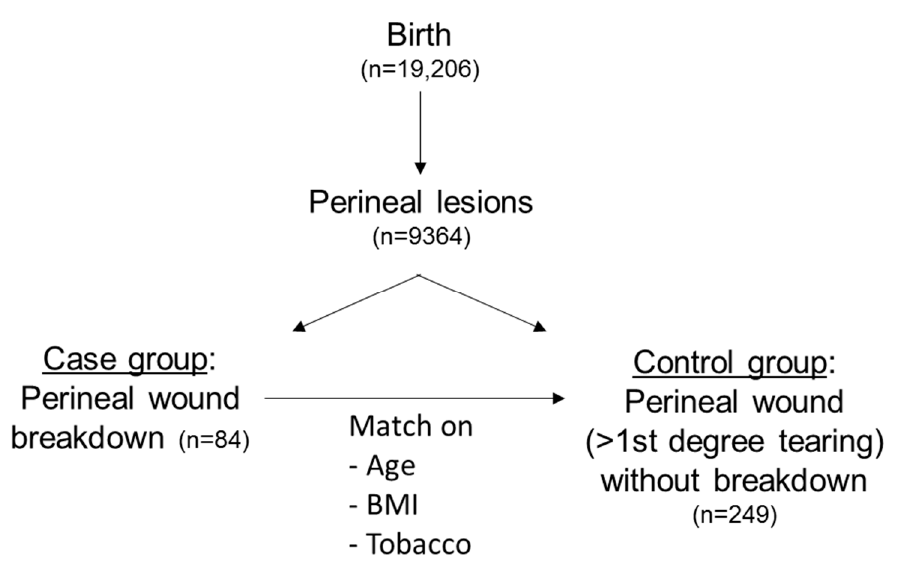
Figure 1. Flow chart of the study.